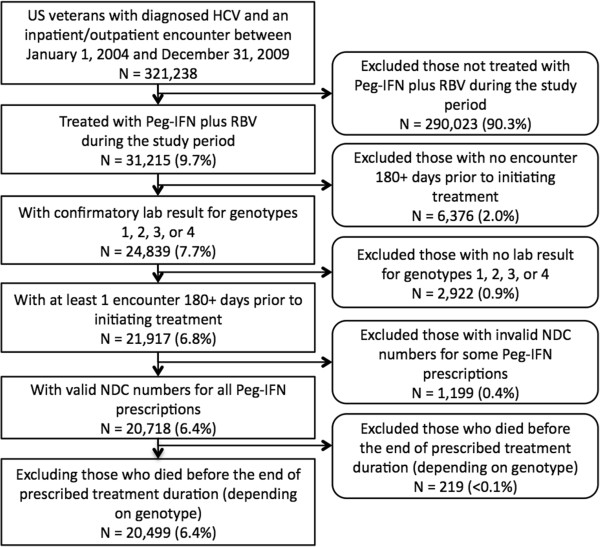
Attrition summary.